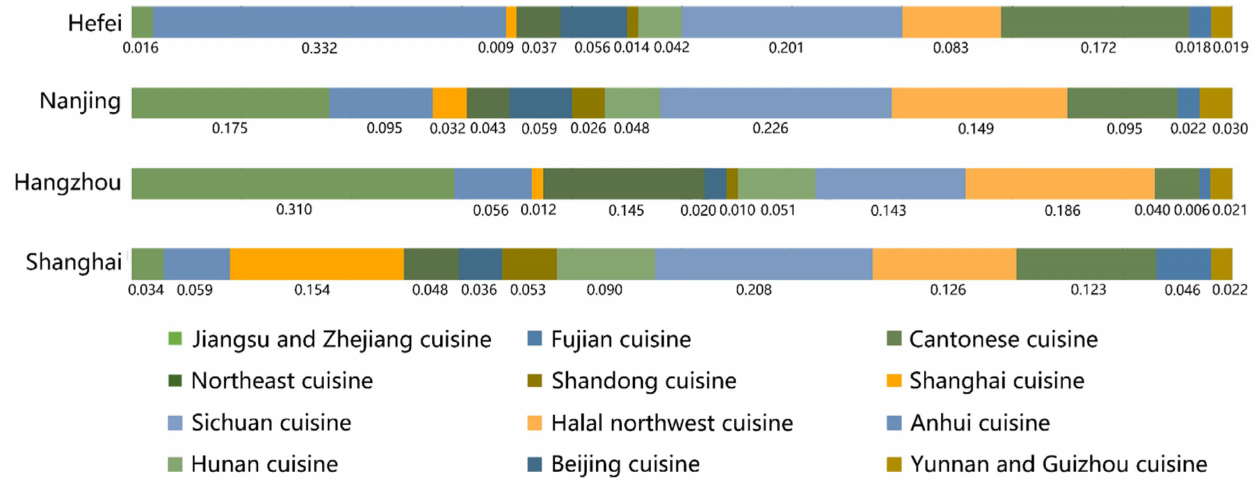
Figure 8. The CGPI of the four central cities in the